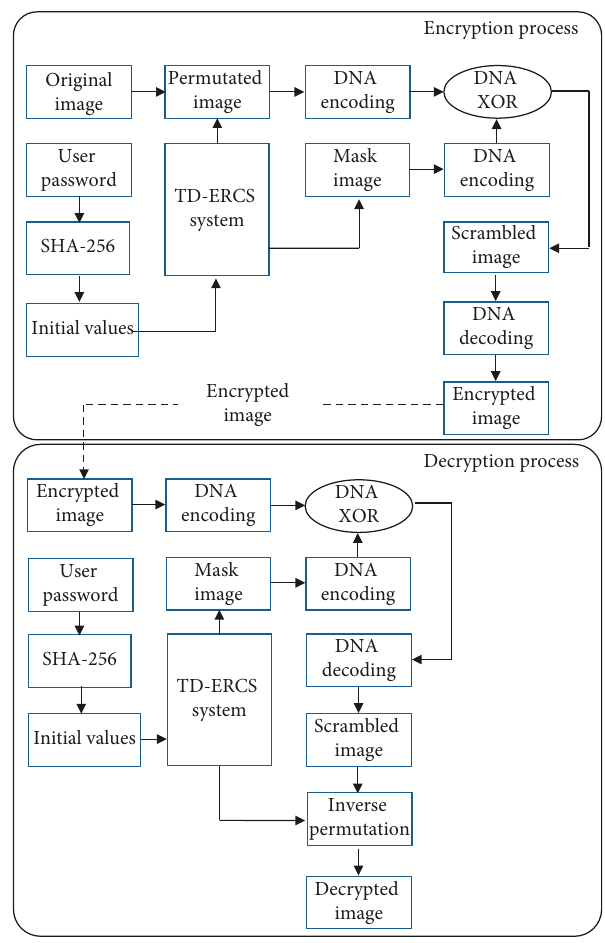
Figure 3: Encryption and decryption in the proposed scheme.